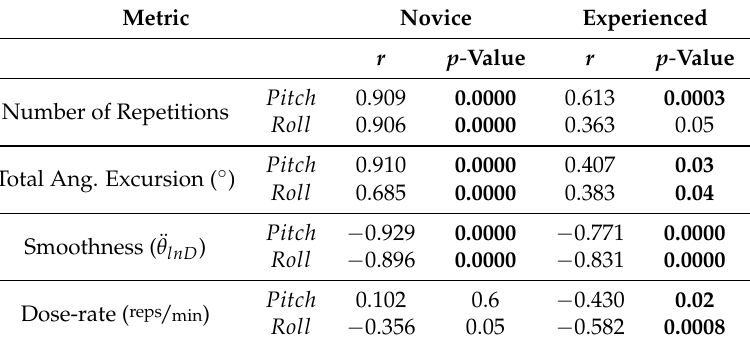
Table 4. Correlation coefficients ( r ) across all trials quantifying the strength of the relationship between trial duration (s) and motor performance metrics for novice and experienced participants. Significant differences ( p <0.05) are indicated with bold